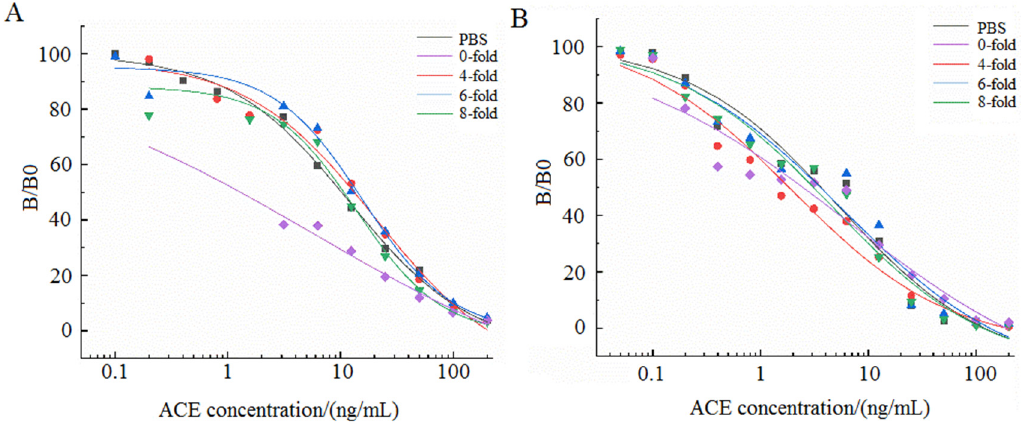
Figure 7. Matrix effect of Chinese cabbage ( A ) and cucumber ( B ) after dilution 0, 4, 6, and 8 fold with PBS solution.